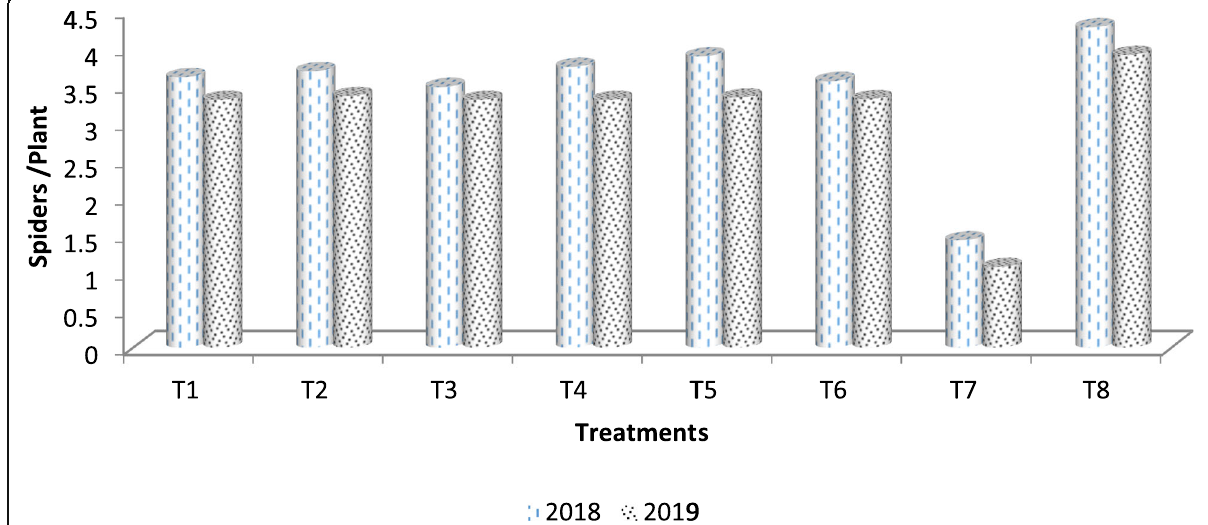
Fig. 3 Effect of different entomopathogenic fungi and neem oil alone and their combination (1:1) against